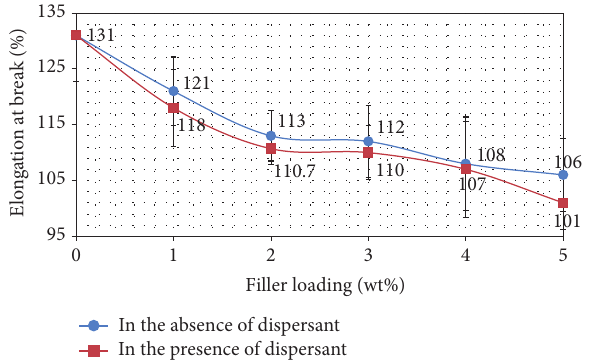
Figure 3: Elongation at break of PP/nano 𝛼 -Al 2 O 3 composites at various